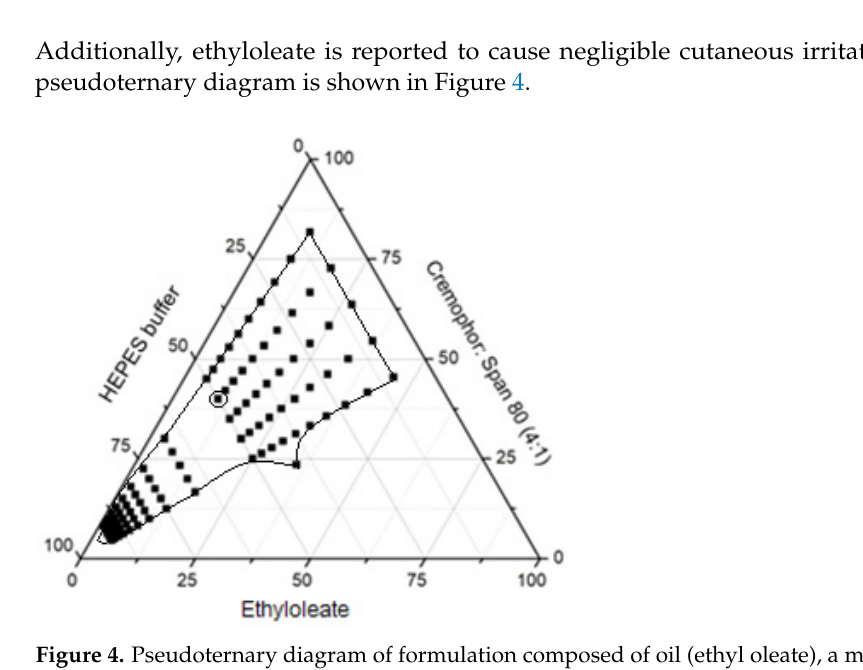
Figure 4. Pseudoternary diagram of formulation composed of oil (ethyl oleate), a mixture of surfac- tants (Cremophor ® and Span 80 ® 4:1 w / w ) dispersed in pH 4.5 HEPES buffer at room temperature. The dots correspond to the compositions that formed homogeneous, translucent systems classified as microemulsions.